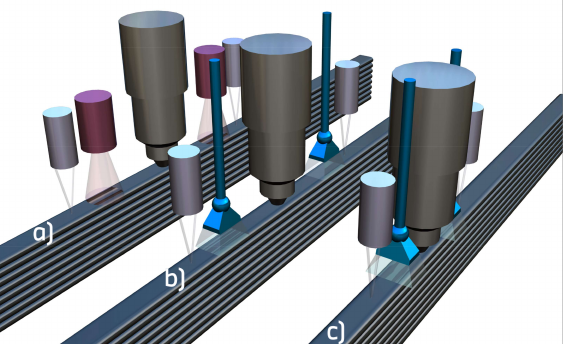
Figure 1. Schematic representation of the three manufacturing setups: ( a ) heating, ( b ) wide cooling with aligned cooling nozzle, and ( c ) narrow cooling with perpendicular cooling nozzle and shorter cooling distance. Infrared heaters are depicted in red, cooling nozzles are depicted in